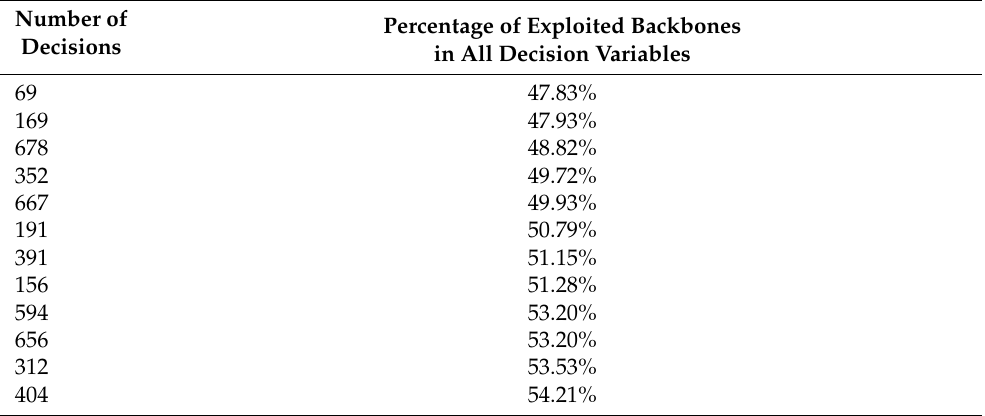
Table A5. Reported random instances from experiment in Figure A8 that are solved in fewer than 1000